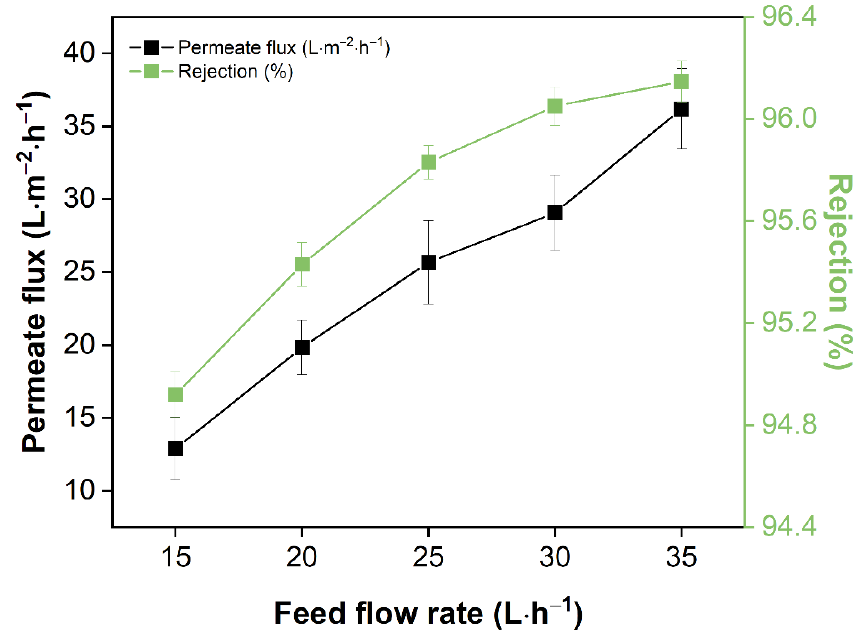
Figure 2. Permeate flux (black dot line) and rejection (green dot line) of reverse osmosis (RO) membrane after 10 h running at different feed flow rates ranging from 15 to 25 L · h − 1 . Operating conditions: feed solution, Na 2 SO 4 ; feed concentration, 2500 mg · L − 1 ; operating pressure, 0.5 MPa; temperature, 18 ◦ C; pH, 7.